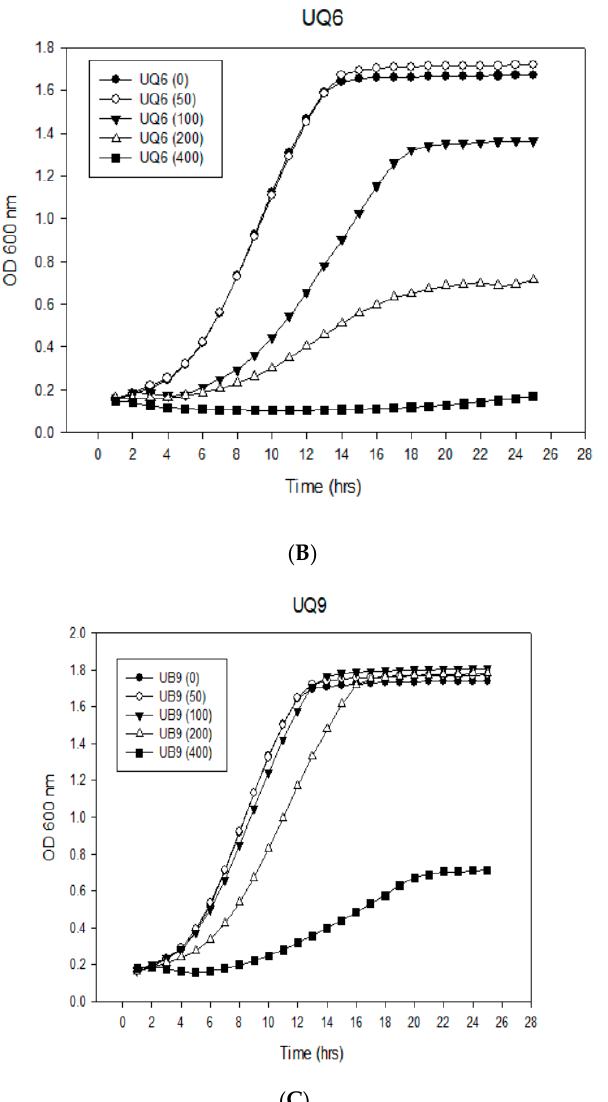
Figure 4. Longer ubiquinones increase the farnesol survival in S. cerevisiae —low aeration. ( A ) UQ knockout, △ coq1 ::pYES. ( B ) UQ6, △ coq1 ::pYES + coq1. ( C ) UQ9, △ coq1 ::pYES + At2g34630. All are triplicate growth curves in YPD with D-galactose and 0 ( ● ), 50 ( ○ ), 100 ( ▼ ), 200 ( △ ), or 400 ( ◼ ) µM farnesol. The triplicate values were all within +5%.